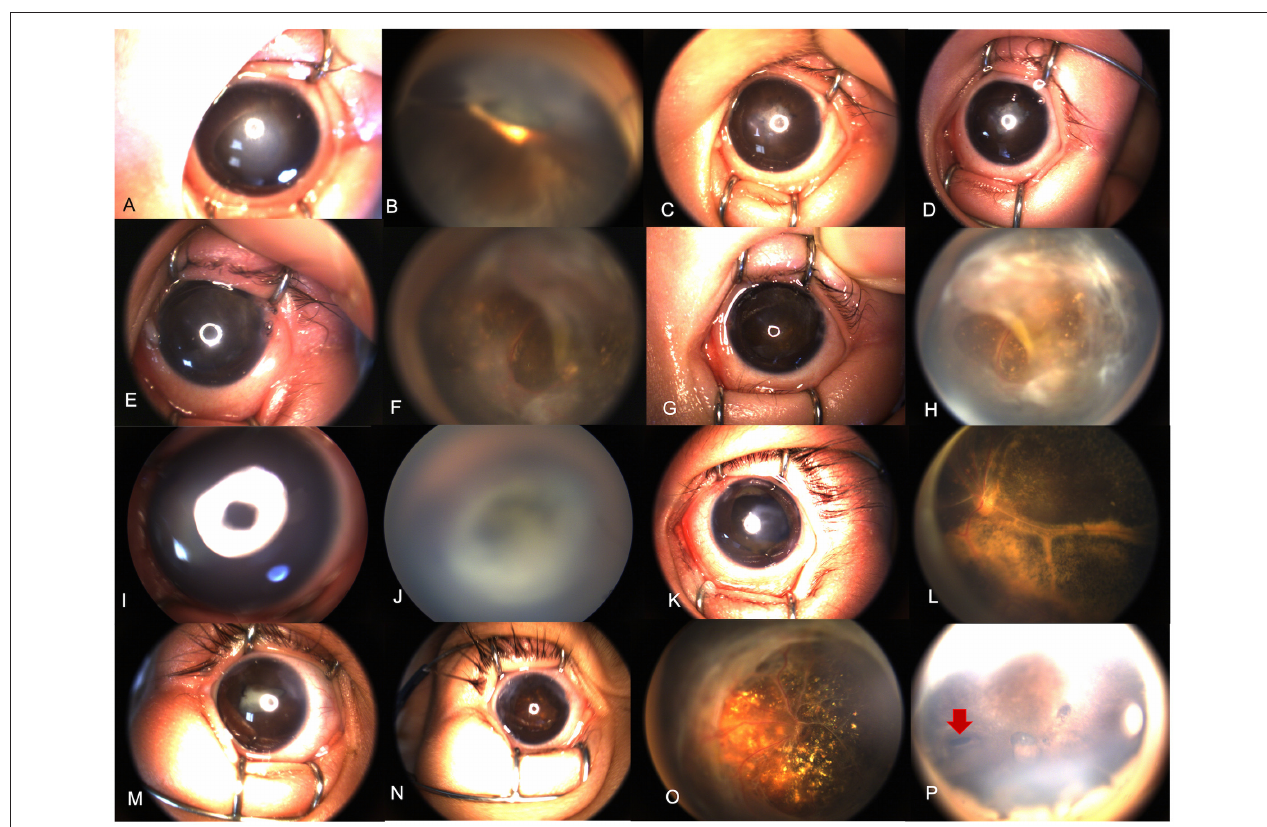
FIGURE 2 | Results of the treatment. (A – H) Retcam images of a 4-month-old FEVR patient (Case 3); (A) a combination of anterior segment anomalies (anterior lens displacement, marked AC shallowing, iridocapsular adhesions, capsule-endothelial adhesion with central corneal opacification) were noted; (B) 1-month after the dry-lensectomy assisted surgery, the depth of AC was normal with pupil occlusion; (C) 3 months after the dry-lensectomy assisted surgery, the corneal opacity was reduced; (D) 8 months after the dry-lensectomy assisted surgery, the corneal is nearly transparent, and a second vitrectomy and RLF peeling was performed. (E,F) 1 week after RLF peeling, the retina was partially reattached in an open-funnel manner; (G,H) 6 months after the RLF peeling, the anterior segment was in a stable and good status with clear cornea and round pupil and open-funnel retina. (I – L) Case 16, a 3-month-old male presented with bilateral total RD complicated with corneal opacity and flat AC. Dry-lensectomy combined with vitrectomy and RLF peeling was performed simultaneously. (K,L) 4 months after the surgery, the corneal opacity was limited and reduced, with nearly reattached posterior pole; (M – O) case 12, a 3-month-old FEVR girl received dry-lensectomy assisted surgery and RLF peeling; (M) before the surgery; (N,O) 7 months postoperatively, the corneal opacity was limited and reduced with round pupil and nearly reattached posterior pole. Subretinal exudates were noted; (P) case 11, 7 months after dry-lensectomy assisted lensectomy, the peripheral iridectomy could be seen (red arrow), helping to prevent secondary angle closure or glaucoma caused by pupil